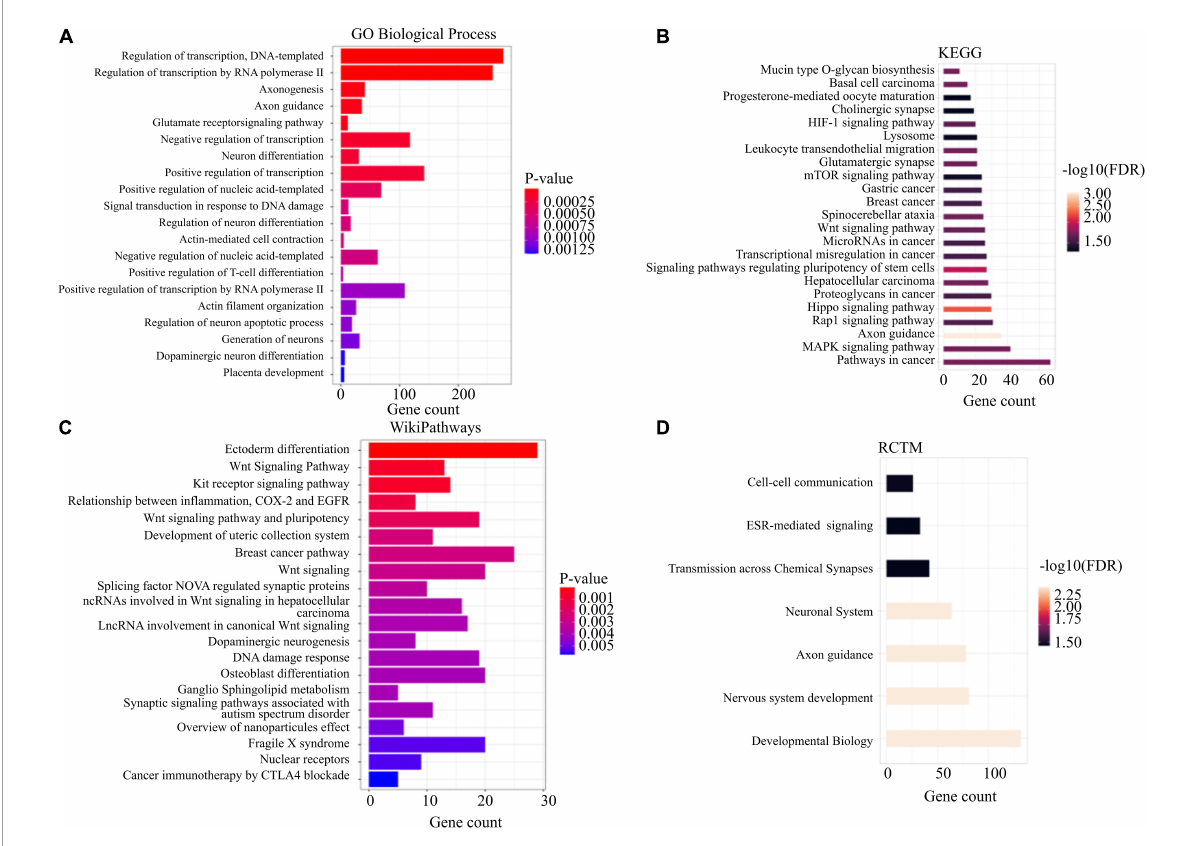
FIGURE3 Functional enrichment. Enrichment analysis was conducted using EnrichR (A,B) and STRING software (C,D) for GO biological process, wikiPathways, KEGG, and RCTM.